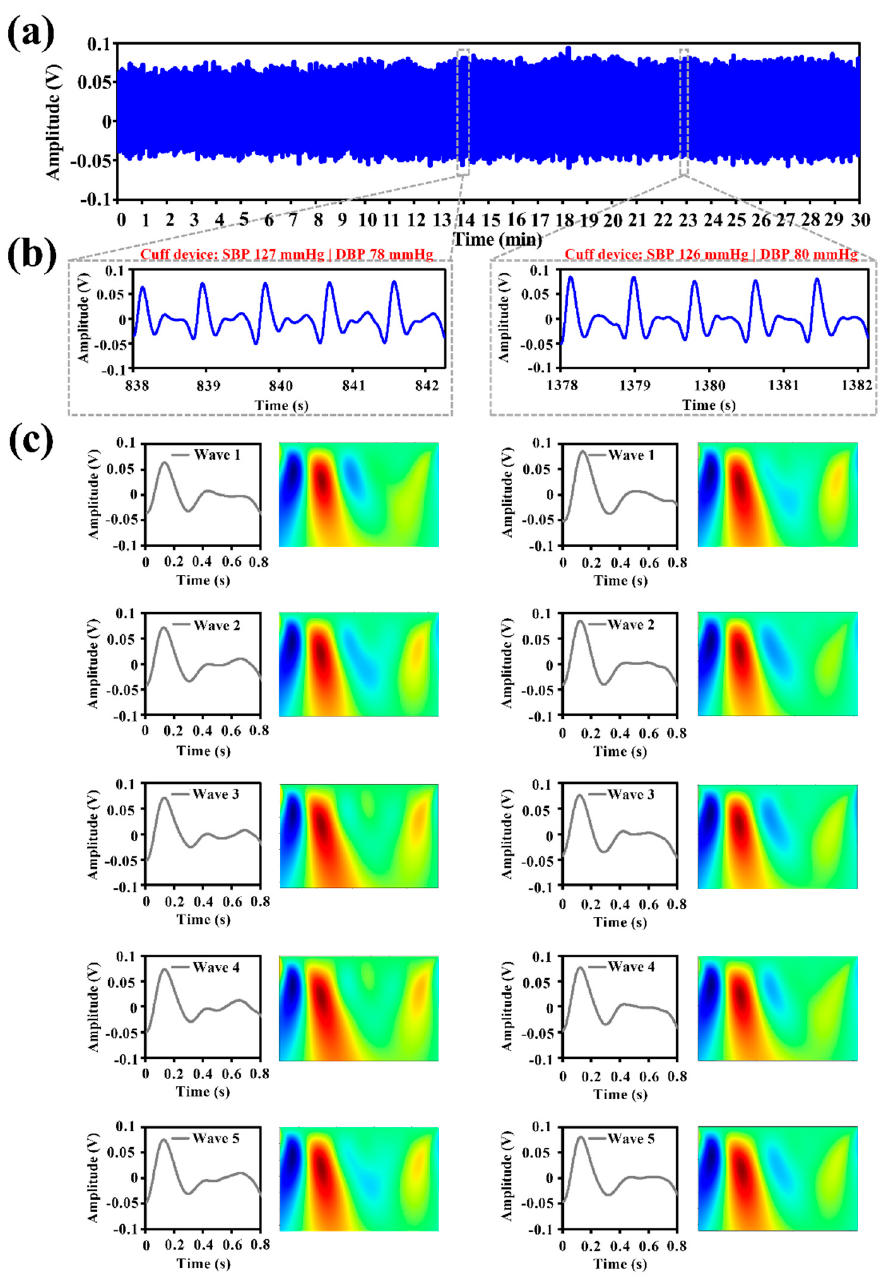
Figure 5. ( a ) IPG signals from a carotid artery for 30 minutes’ measurement. ( b ) Five consecutive IPG waveforms before and after the operating time of the cuff device. ( c ) IPG signal segmentation and further continuous wavelet